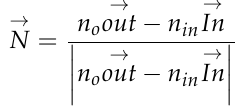
Figure 6. The upper half of the double freeform surface lens. The curved baffle plate with 45 degrees is chosen to form the clear cutoff line, as shown in Figure 7.